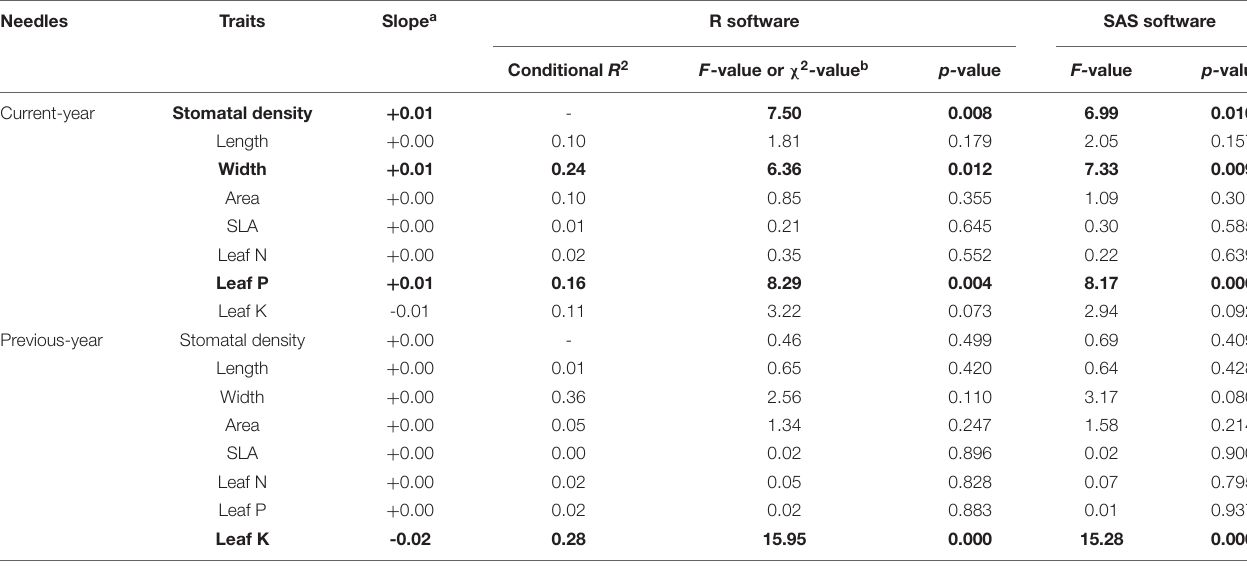
a + and - indicate an increase and decrease, respectively, from urban to rural sites. b F-value is for stomatal density using GLMMPQL and χ 2 -value is for other traits using GLMM. The bold value indicates that the change of traits along the urban-rural gradient was significant.